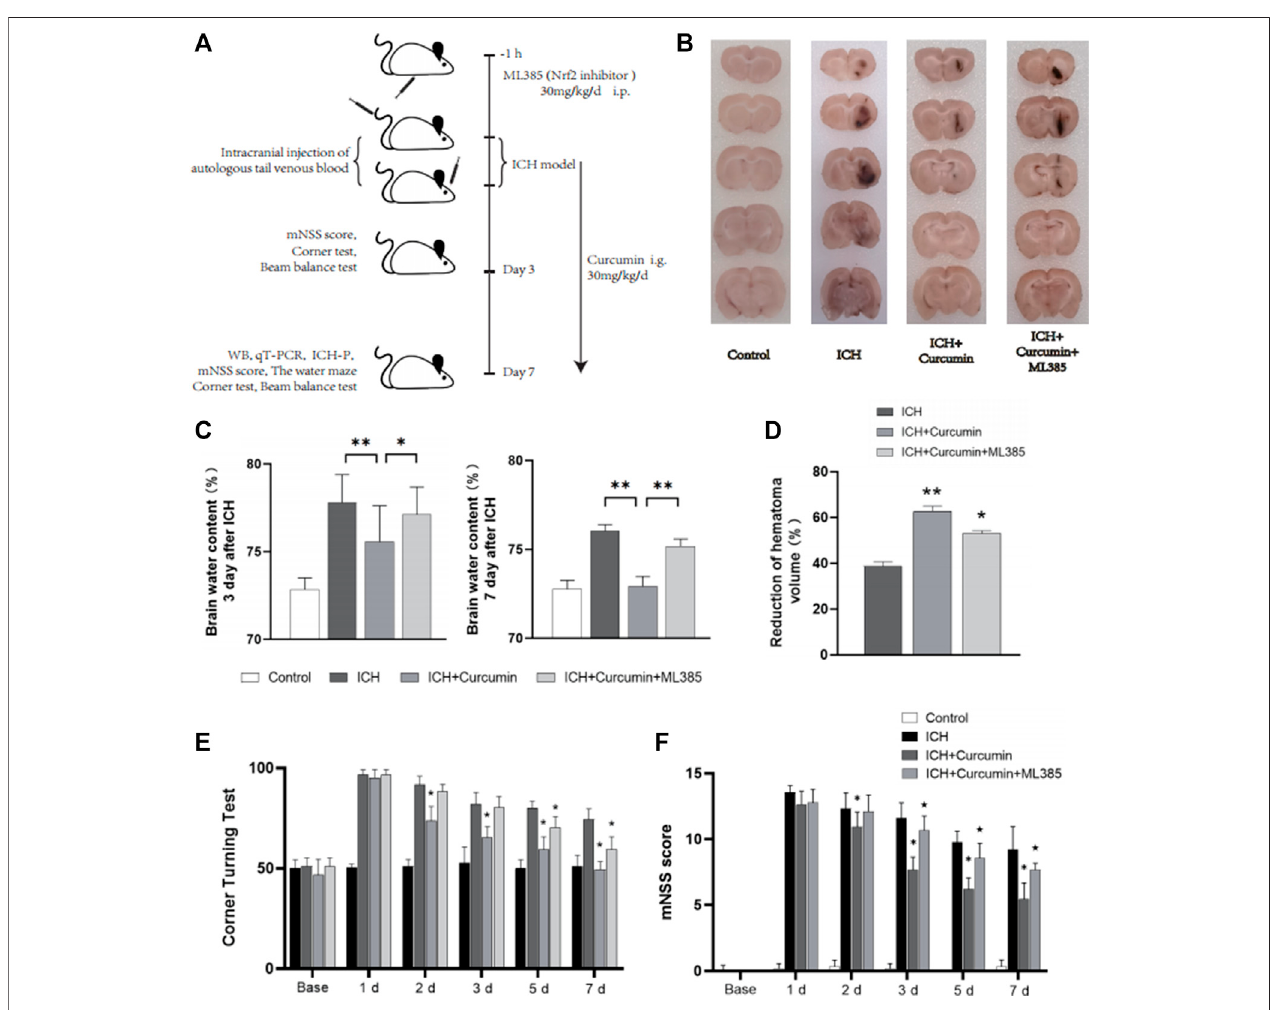
FIGURE 6 | In vivo experimental procedures and neurological function evaluation. (A) Graphical abstract of the in vivo study. (B) The coronal sections of the brain tissue were prepared following sucrose dehydration (5 mm), to evaluate intracranial hematoma. (C) The cerebral water content was measured 3 and 7 d after ICH. (D) Thereductioninthehematomavolumeisreportedasapercentage. (E) Statisticalanalysisofthecornerturntest. (F) ThemNSSscoreofratsineachgroup.Thedataare shownasthemeans±SDof n =3samples/groupandatleastthreeindependentexperimentswereperformed.Statisticalanalyseswereconductedusingtwo-way ANOVA. Compared with ICH group, *, p < 0.01 and **, p < 0.01. Compared with ICH + Curcumin group, + , p < 0.01.